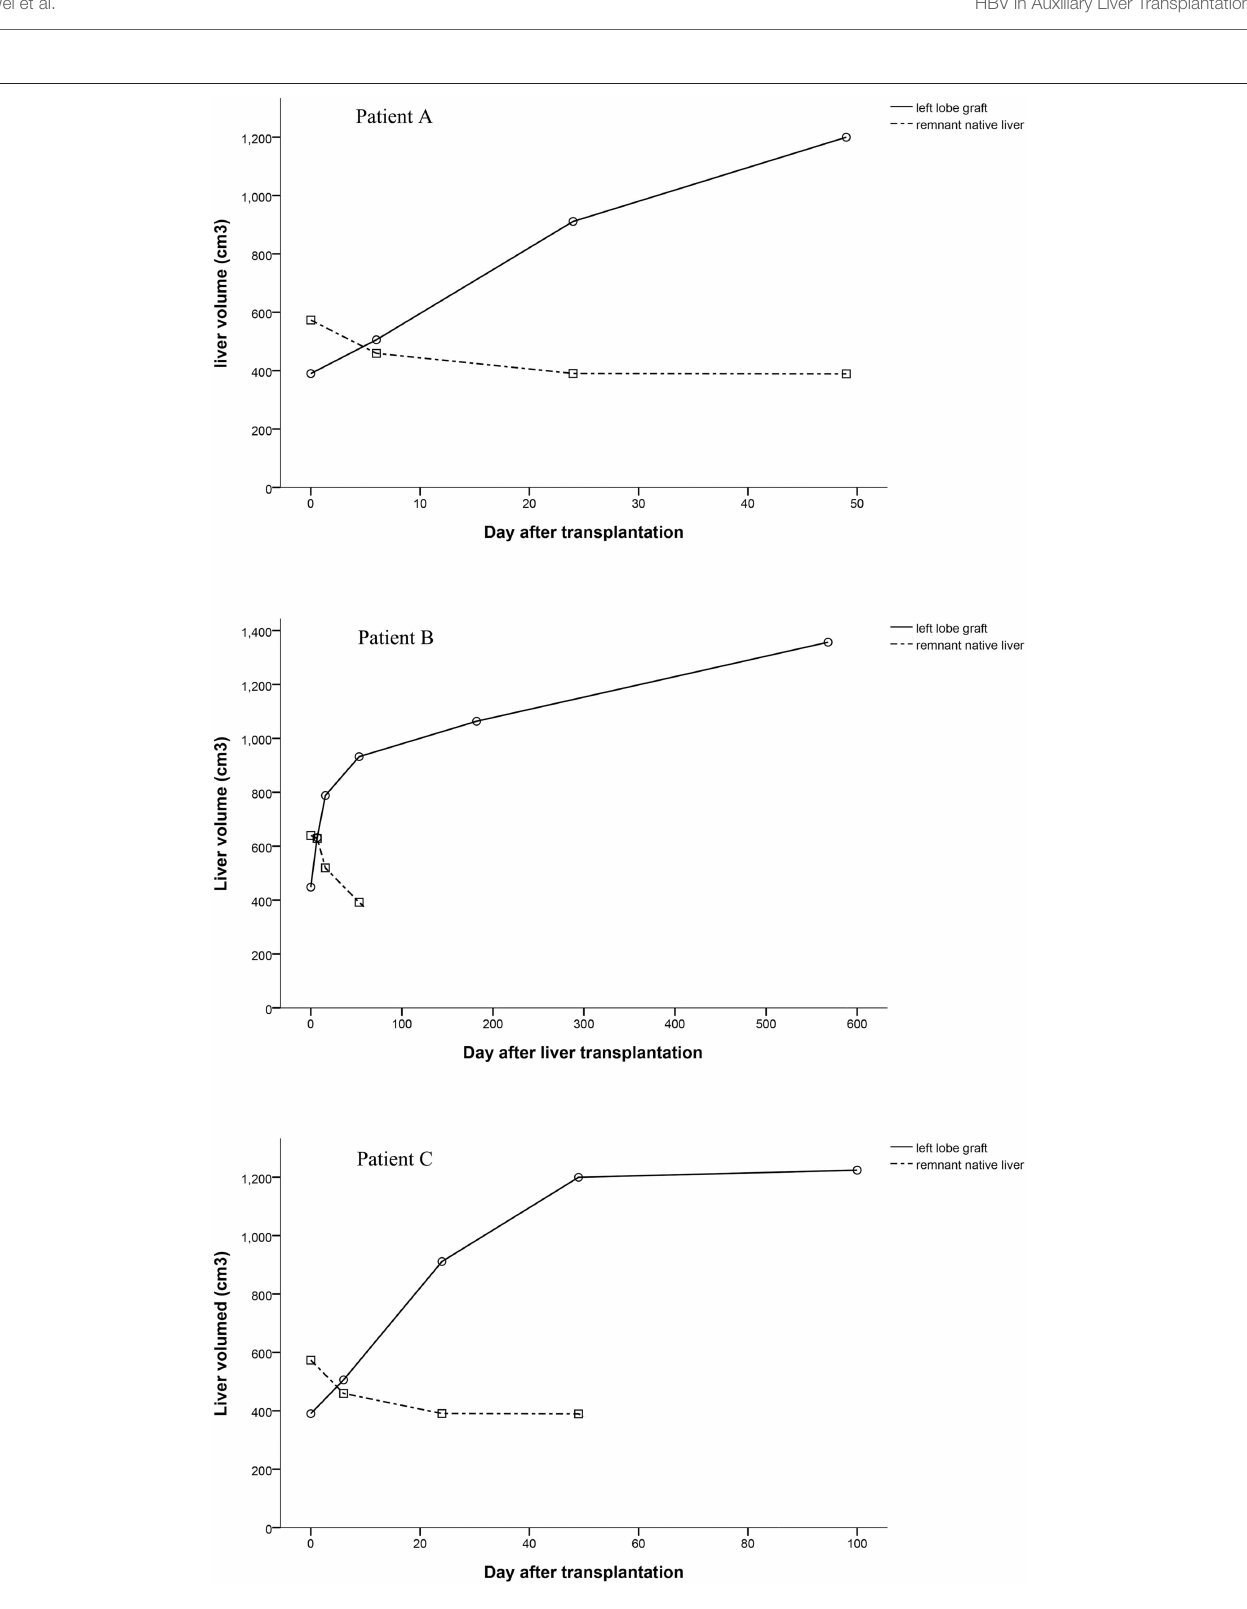
Frontiers in Medicine |